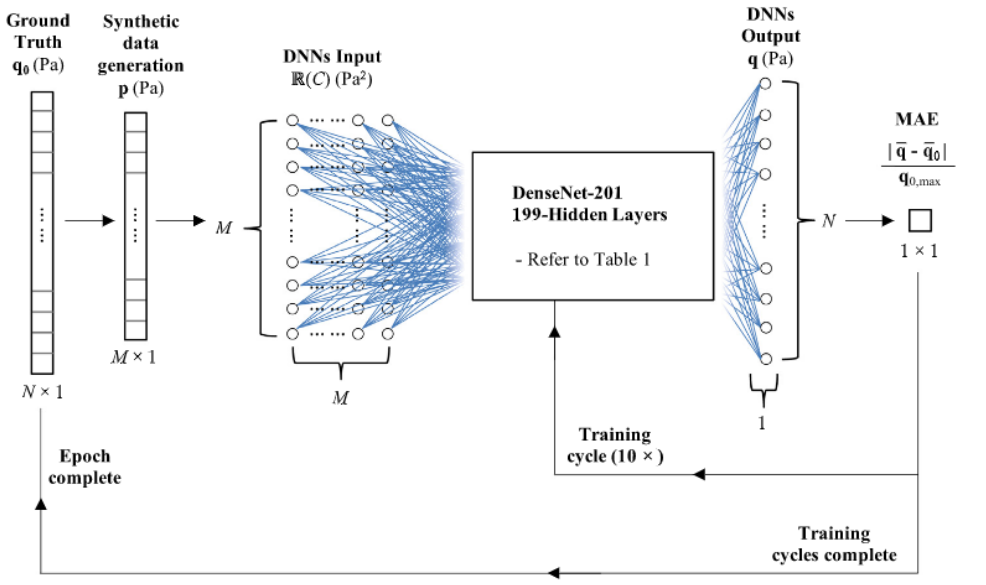
Figure 8. Architecture of the DNN model Xu et al. [119]. Reprinted with permission from